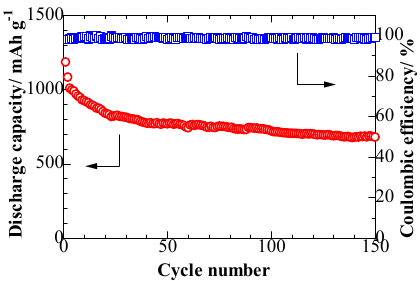
Figure 6. Cycling performance of S/Mn 3 O 4 cathode at 0.1 C.